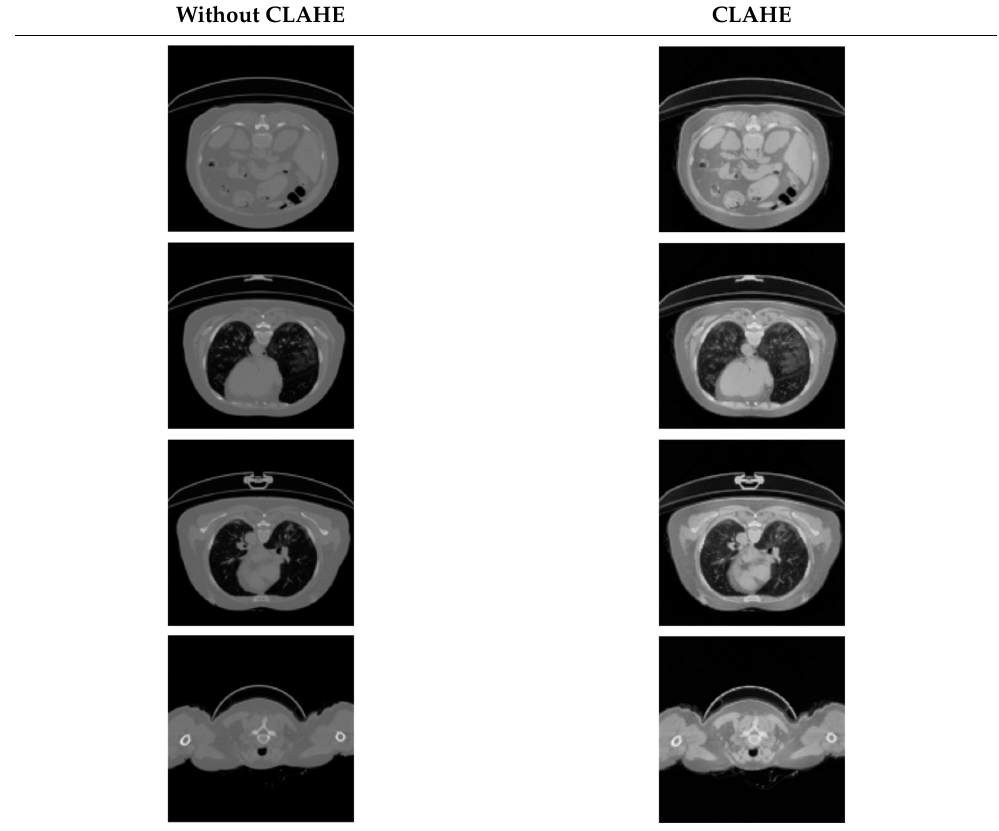
Table 4. Comparison before and after applying CLAHE preprocessing to CT-scan. Without CLAHE CLAHE